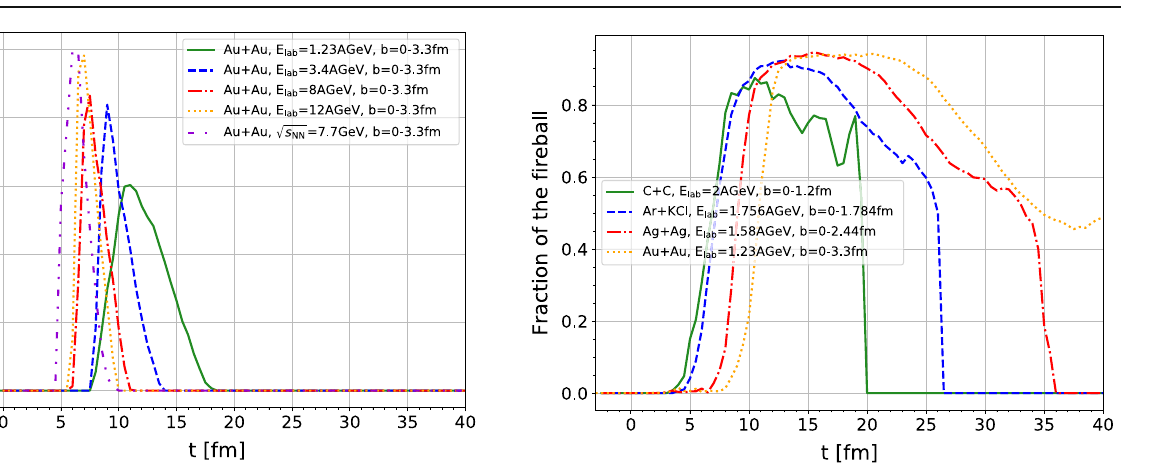
Fig. 14 Time evolution of the average fraction of the system satisfying the conditions X < 0 . 3, Y < 0 . 3, ε > 500 MeV / fm 3 for Au+Au collisions, 0–5% centrality class, at E lab = 1.23, 3.4, 8, 12 AGeV and √ s NN = 7.7 GeV